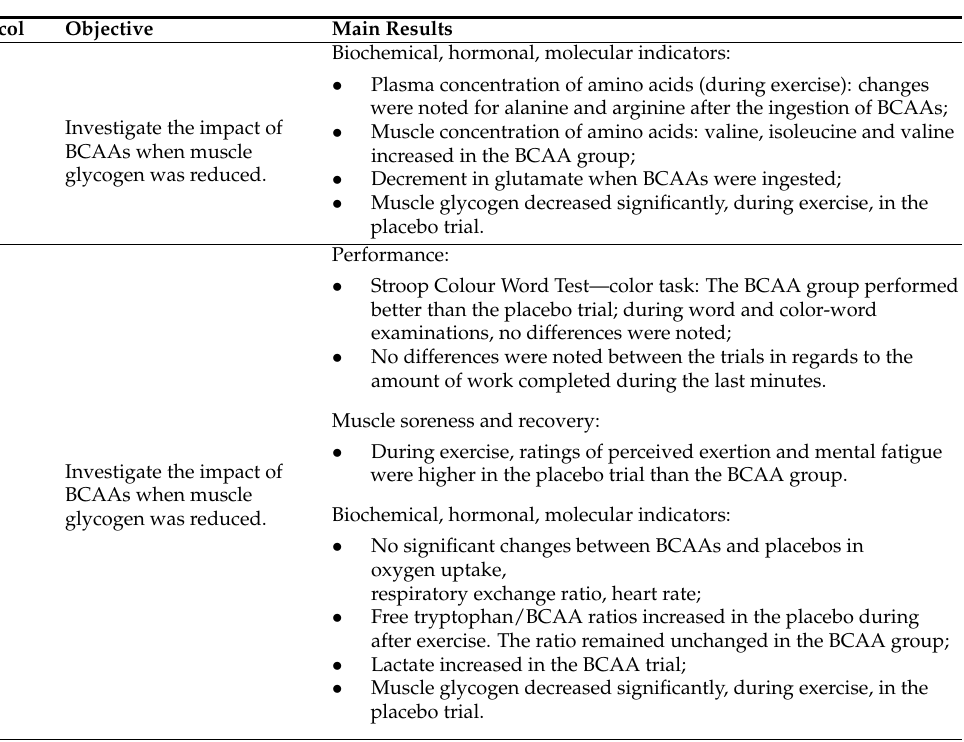
Table 1. Characteristics of studies that included participants with training experience and branched-chain amino acid